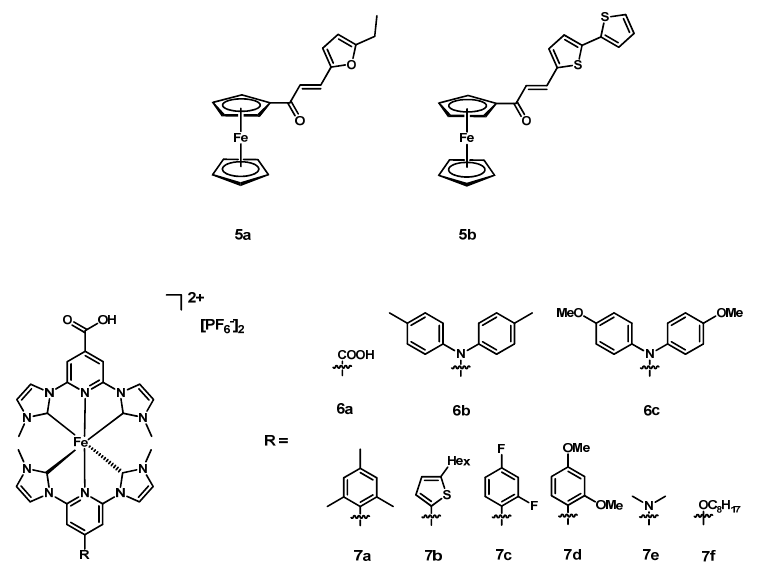
Figure 4. S tructure of dyes 5a – b , 6a – c, and 7a – f . The UV–Vis spectra of 5a and 5b showed a broad absorption band at 486 and 483 nm, and more intense bands were observed at 345 nm for 5a and 385 nm for 5b . A stronger red shift was observed for the latter, which was attributable to the presence of two thiophene rings in this complex. From DFT calculations, it emerged that the HOMO–LUMO gaps were 3.488 eV and 3.153 eV for 5a and 5b ; hence, the second one was characterized by an easier charge transfer process. In any case, the HOMO levels of 5a and 5b remained lower than the I − /I 3 − couple redox potential. Therefore, it could be used as redox mediator for restoring both the oxidized